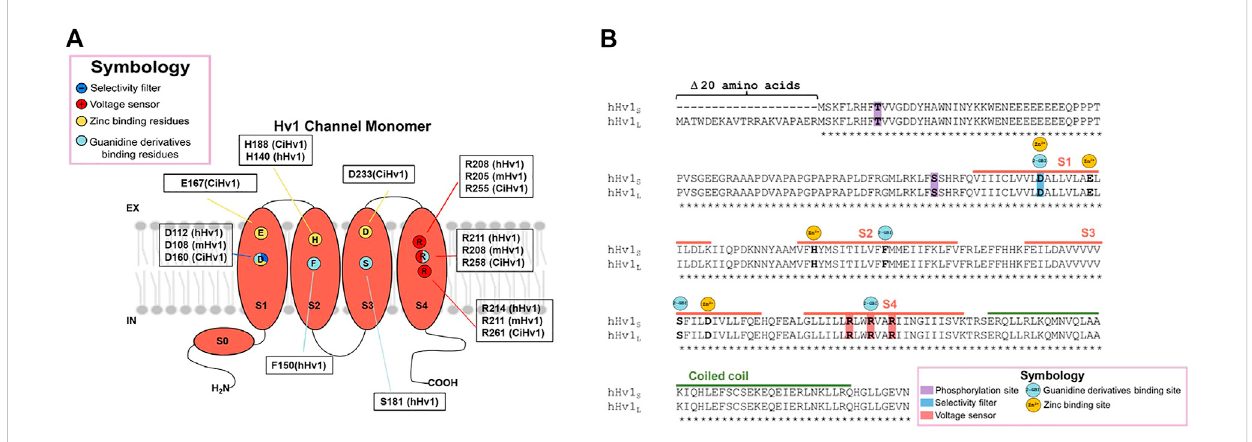
FIGURE 2 Structure of the Hv1 channel and molecular determinants of Zn 2+ and Guanidine derivatives binding sites. The molecular determinants in the interaction of the protein with the classical inhibitors zinc ion and guanidine derivatives are pointed in (A) the monomeric channel cartoon, indicating in what species were discovered the interaction with the chemical compounds and, (B) in the sequence alignment between long and short Hv1